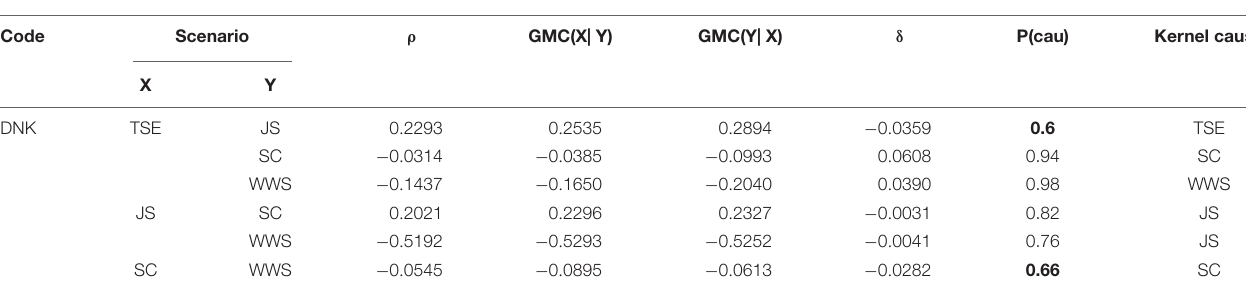
TABLE 7 | Summary of GMC for